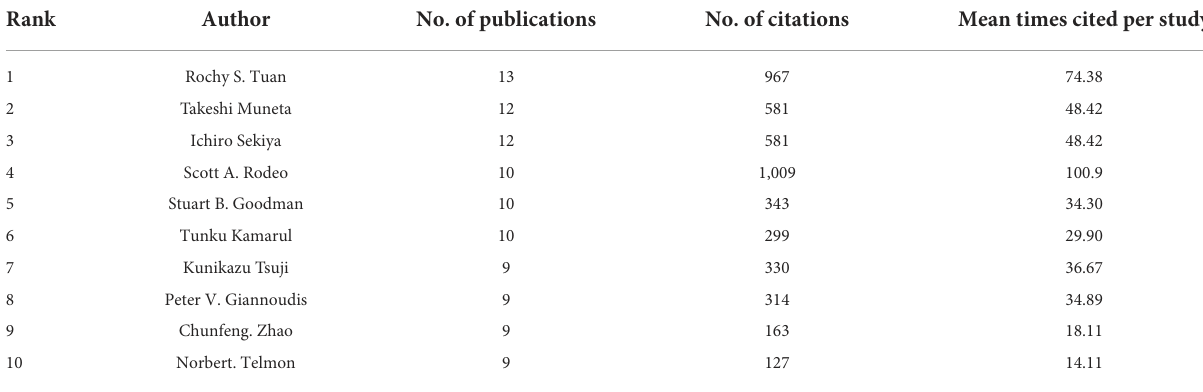
TABLE 4 The top 10 authors in the MSCs for orthopedics ranked by publication number.